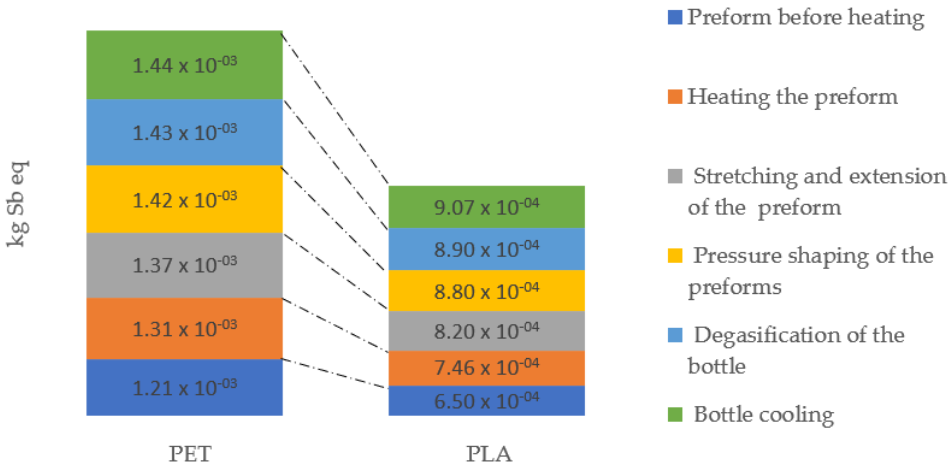
Figure 7. Abiotic depletion emissions throughout the entire bottle shaping process.